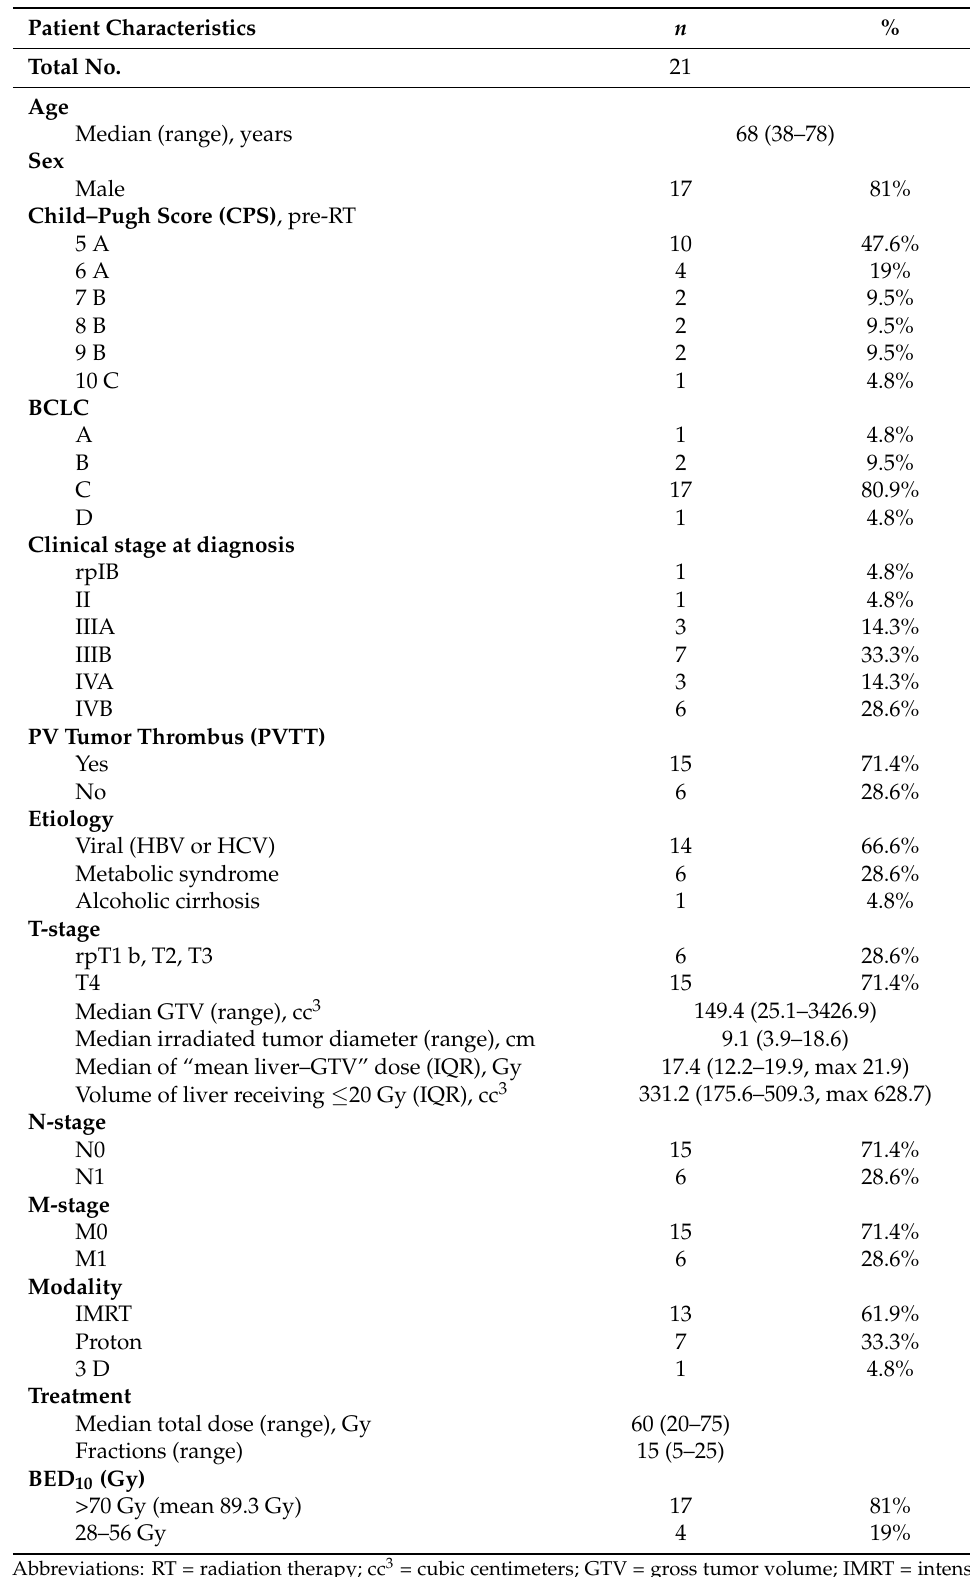
Table 1. Patient, tumor, and treatment